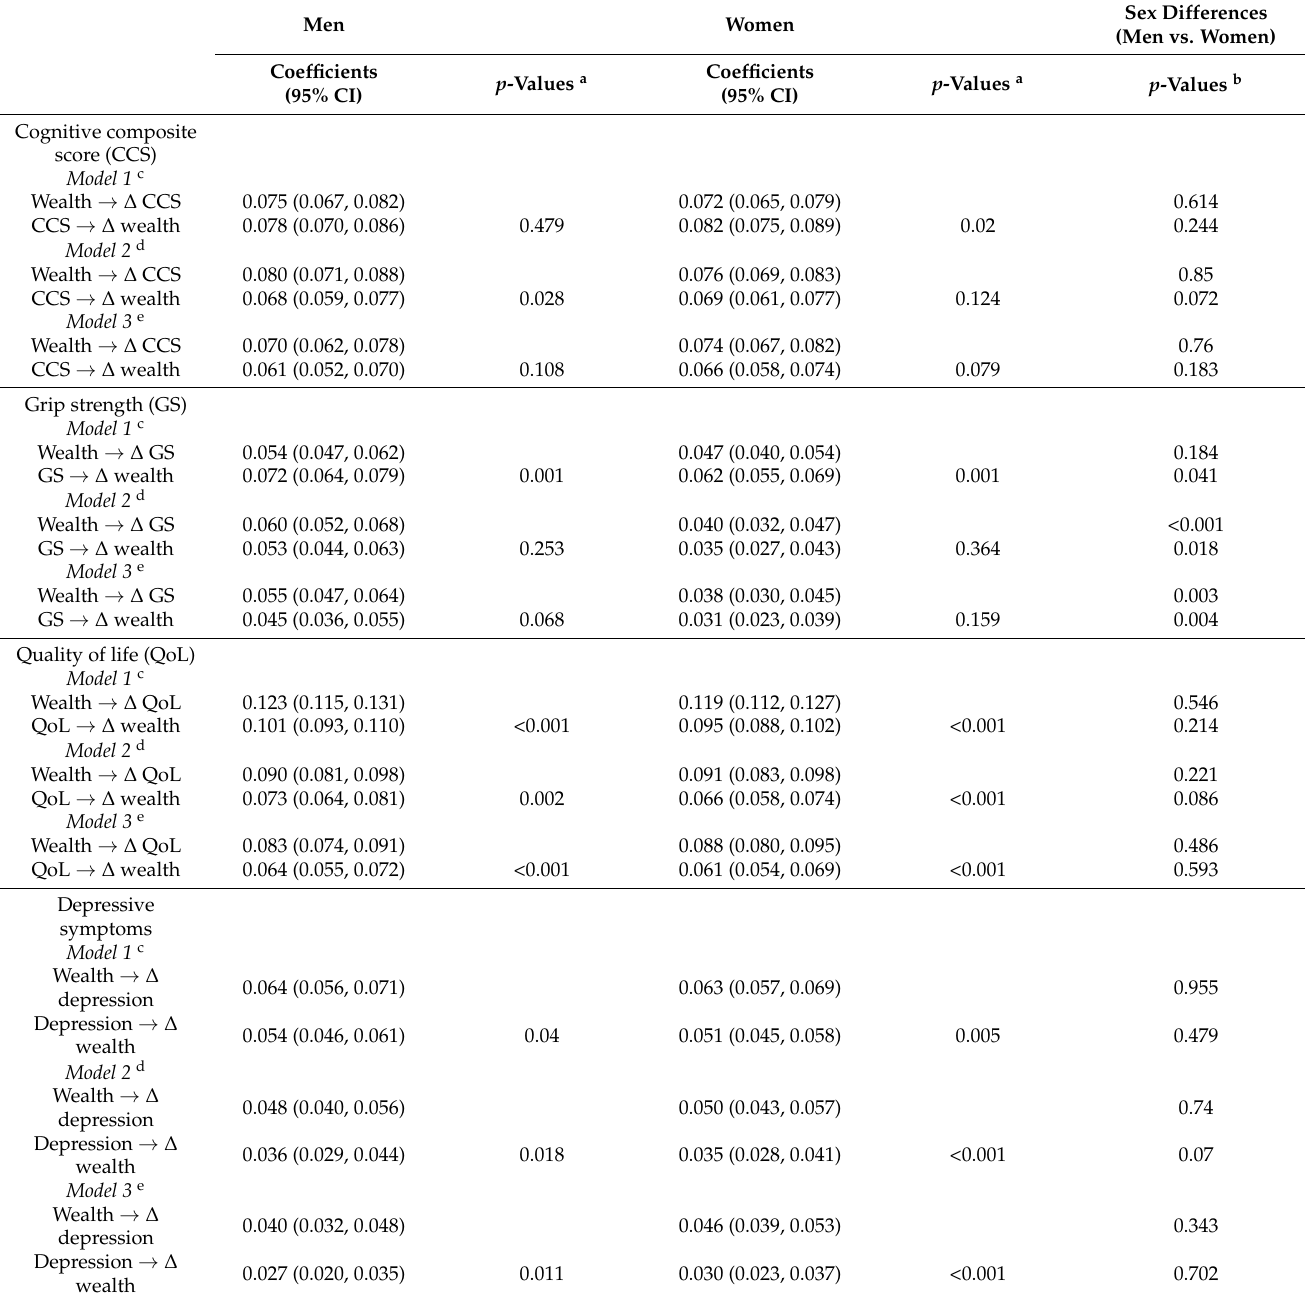
a p -values for differences between the reciprocal associations (i.e., associations between income/wealth and health changes and between health and trajectories of income/wealth). b p -values for sex differences within each of the reciprocal associations. c Model 1: unadjusted.